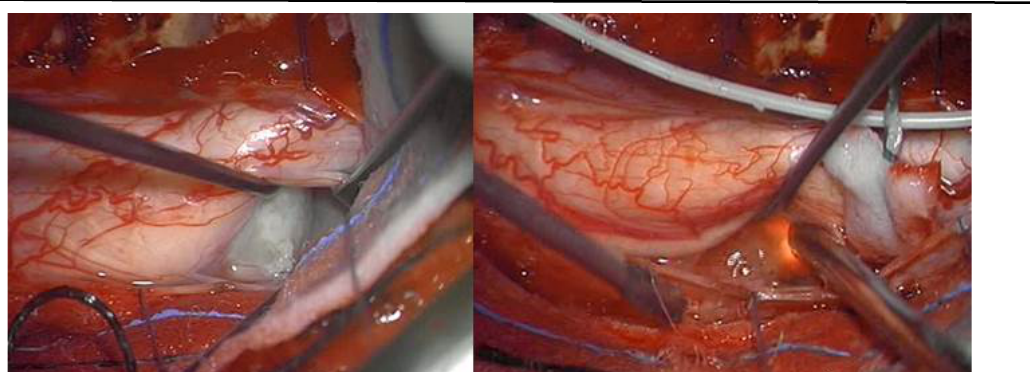
Figure 1. Surgical view from the micrscope. The tumor was completed cover by spinal cord. With endoscopy helping it was possible the complete resection.